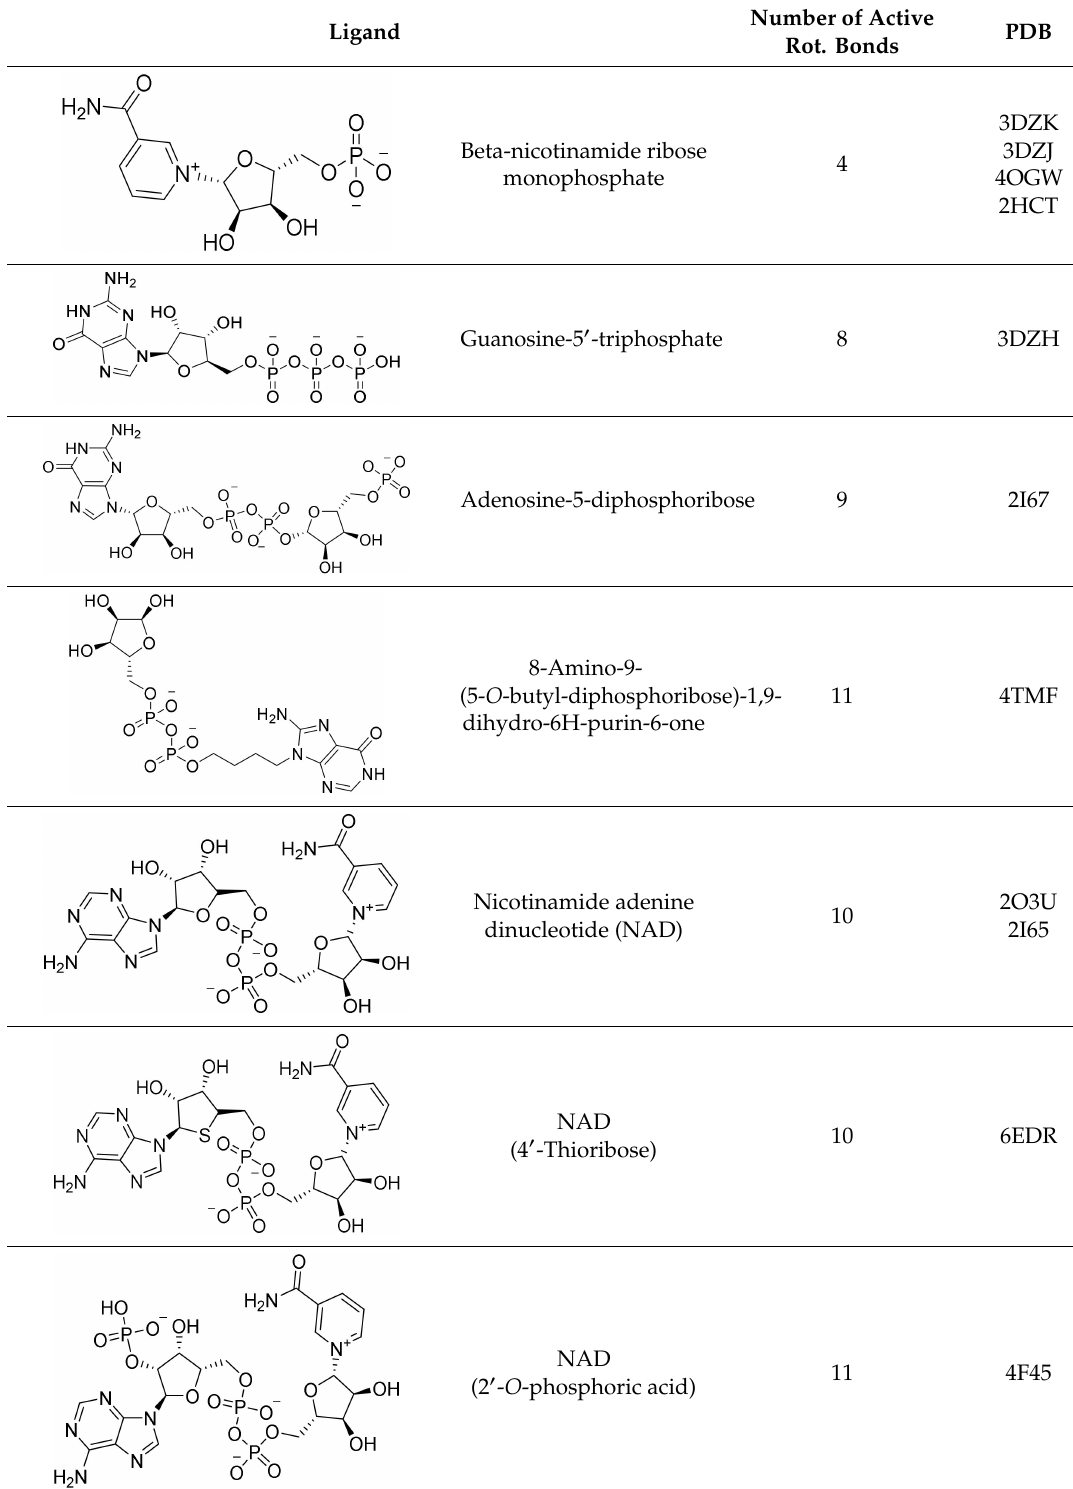
Table 2. A list of structures used to investigate the performance of pose prediction. These ligands, which are predominantly biologically relevant substrates for CD38, are generally larger and more flexible in comparison to the drug-like compounds commonly docked during virtual